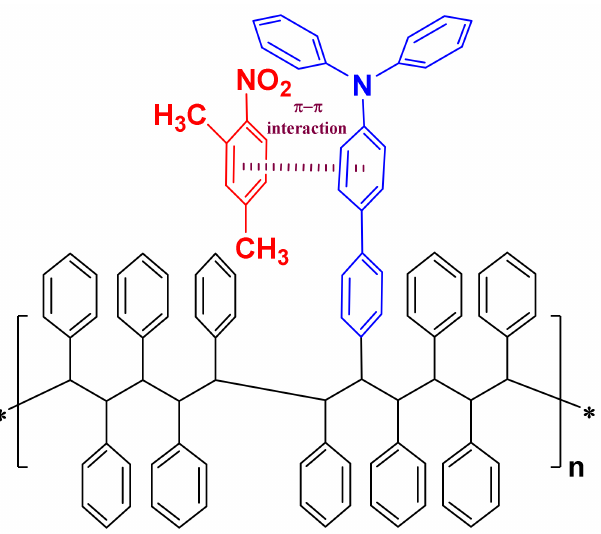
Figure 8. The proposed complexation mechanism of copolymer P5 with